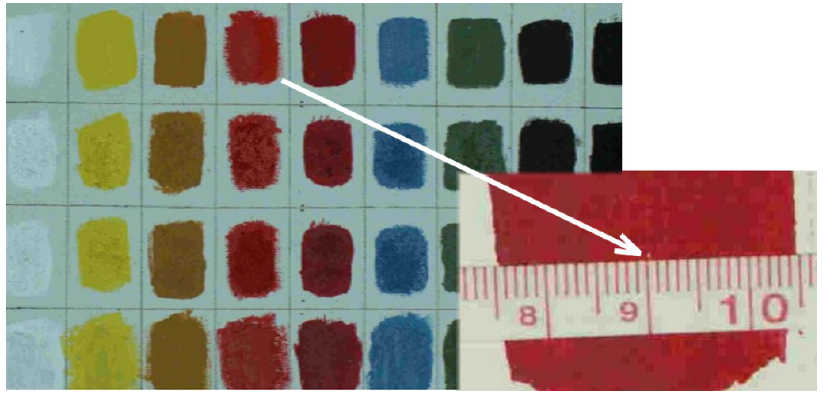
Figure 6. White arrow shows photograph of a crater produced by 20 laser pulses (pulse energy 30 mJ) in acryl painting layer with cadmium red pigment.